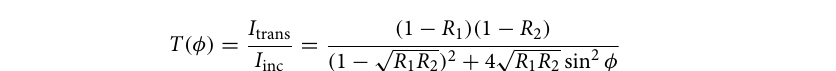
Table 1. OLED layer thicknesses